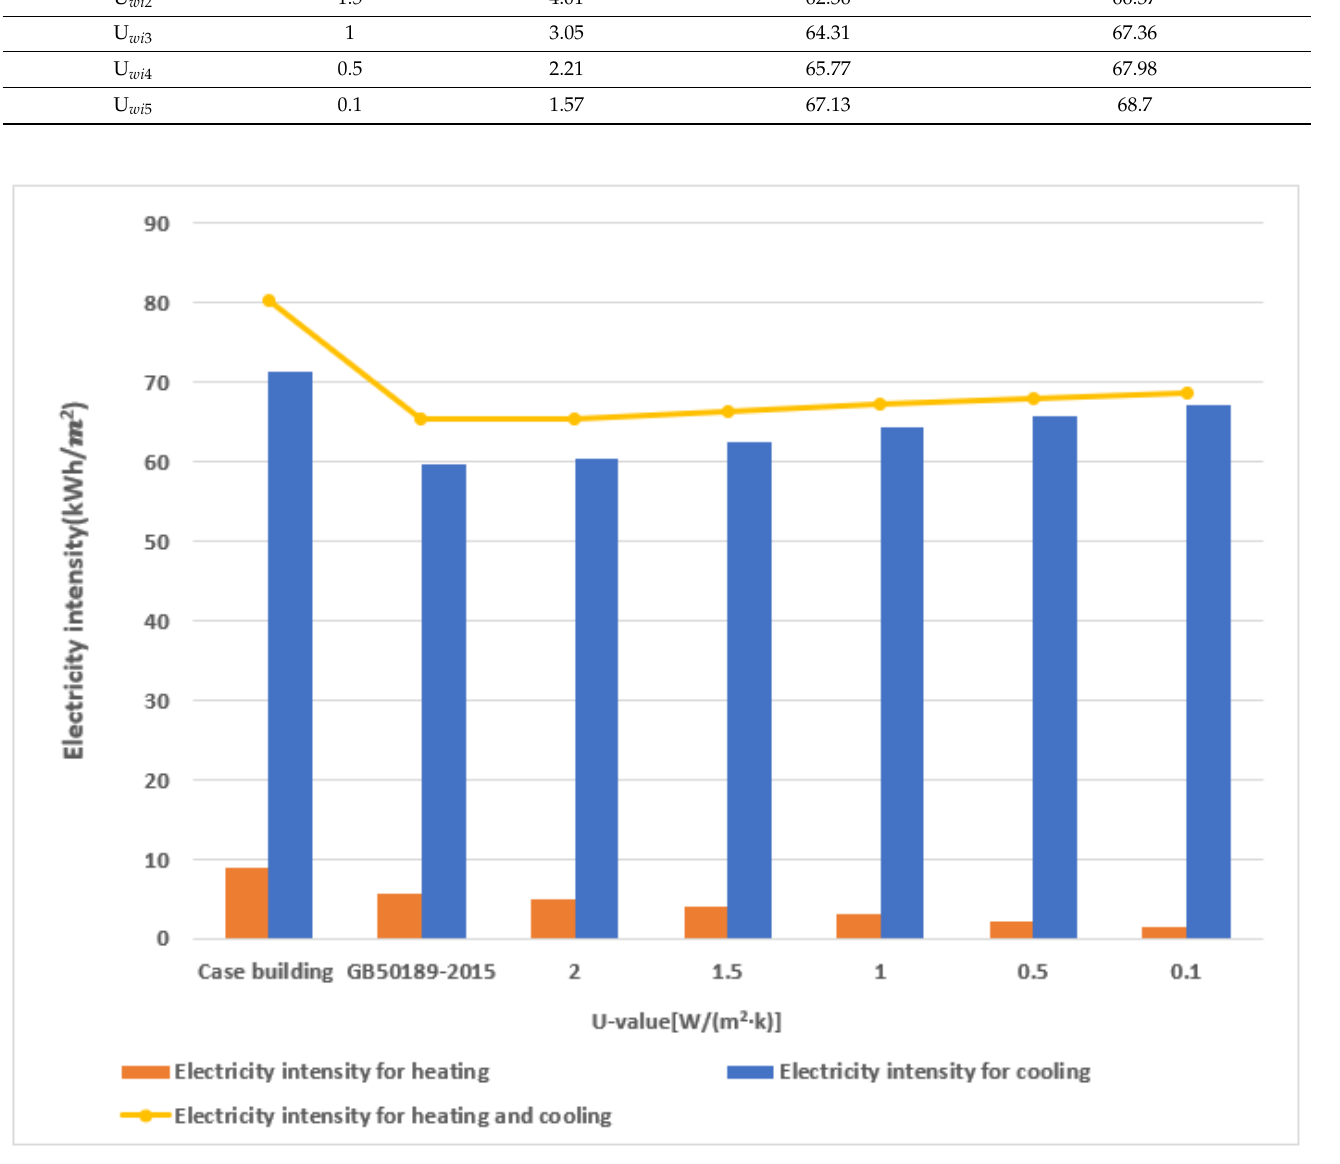
Figure 8. Figure 8. Electricity intensity for heating and cooling using different U-values for window energy retrofitting.